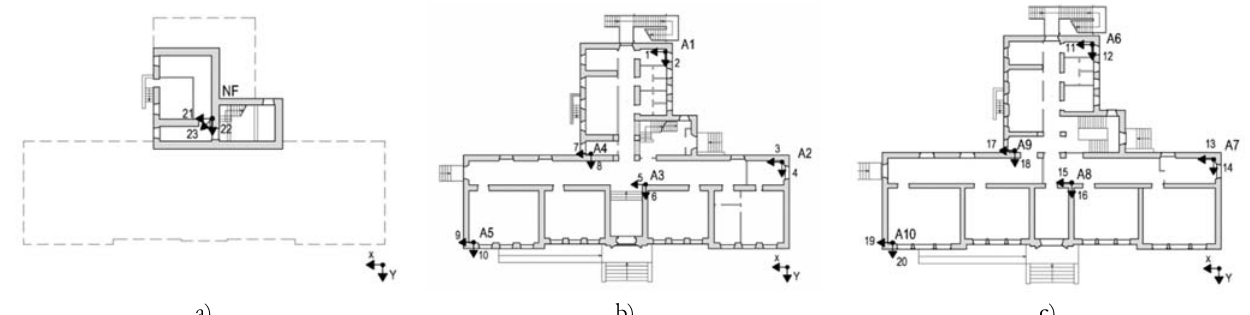
Figure 6: Location of the accelerometers: a) basement, b) raised ground floor, c) first floor